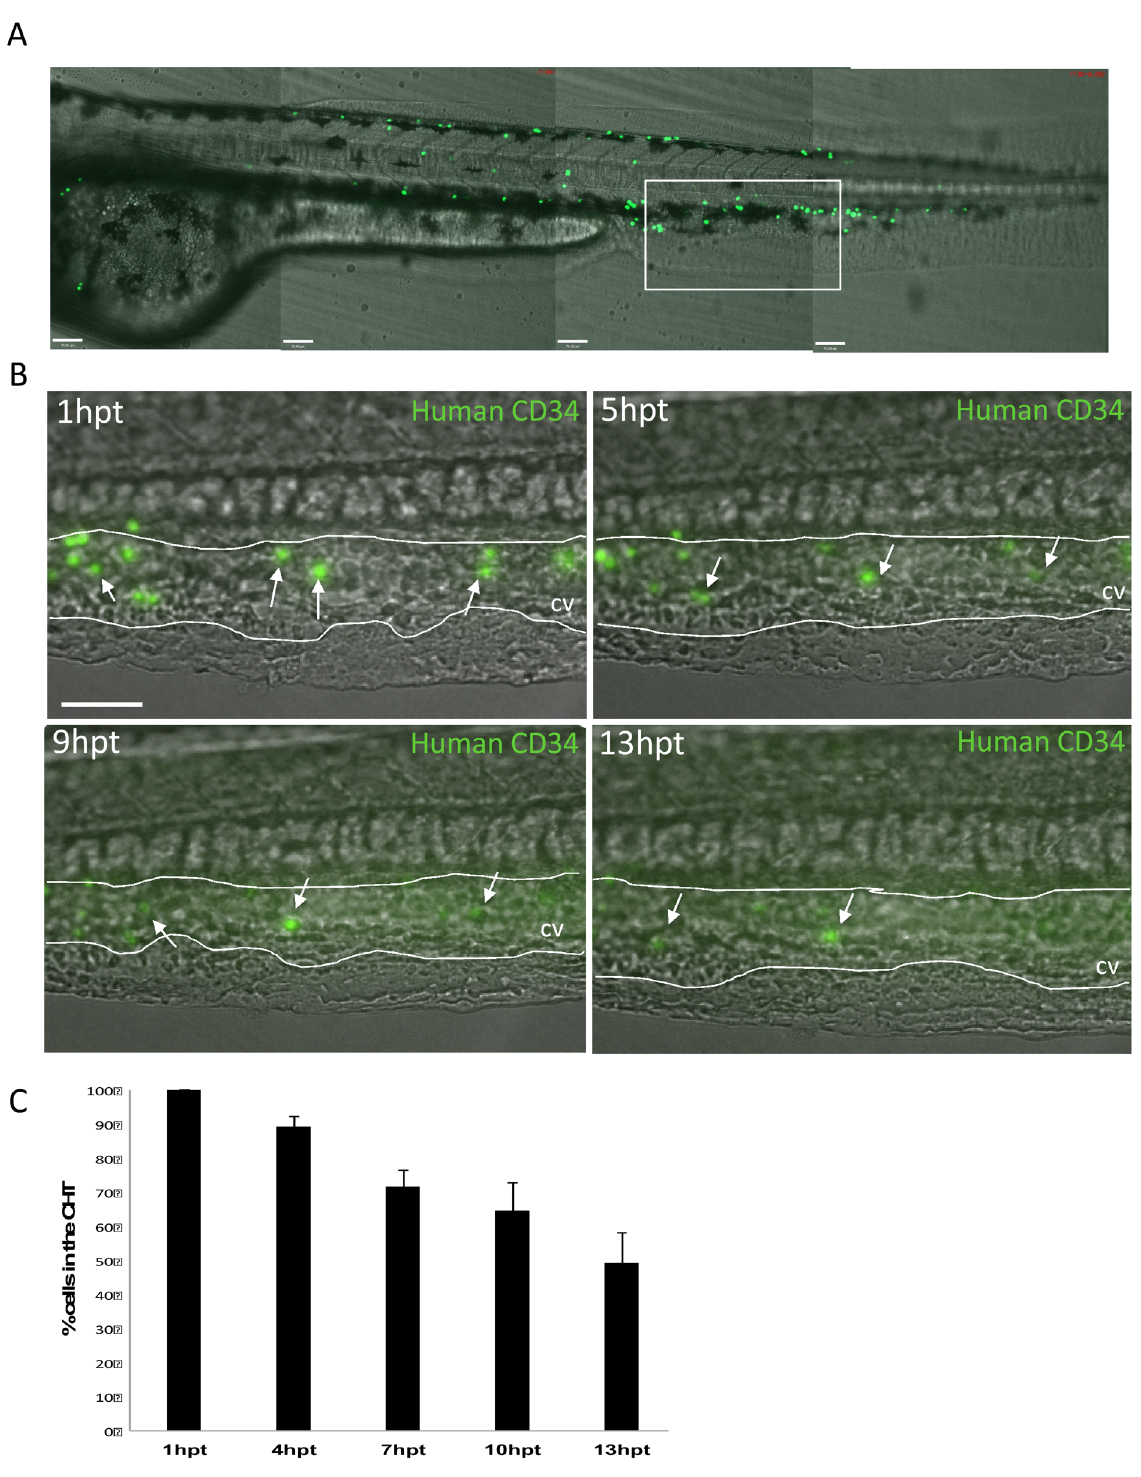
Figure 4. Injected human CD34 cells quickly appear in the zebrafish Caudal Haematopoietic Tissue (CHT). ( A ) Stitched Z-stack of whole Zebrafish larvae trunk highlighting the CHT (white rectangle). ( B ) Representative Z-Stack images of fluorescein labelled human CD34 cells present at the CHT at 1hour post transplantation (hpt), 5hpt, 9hpt and 13hpt. Scale bar=80μm. ( C ) Quantification of the decreasing total number of CD34 human cells in the CHT in embryos injected with fluorescein labelled human CD34 cells (n=5). First image of the CHT taken at 1hpt representing 100% of cells within the CHT and quantified following single emrbyos at 5hpt, 9hpt and 13hpt.